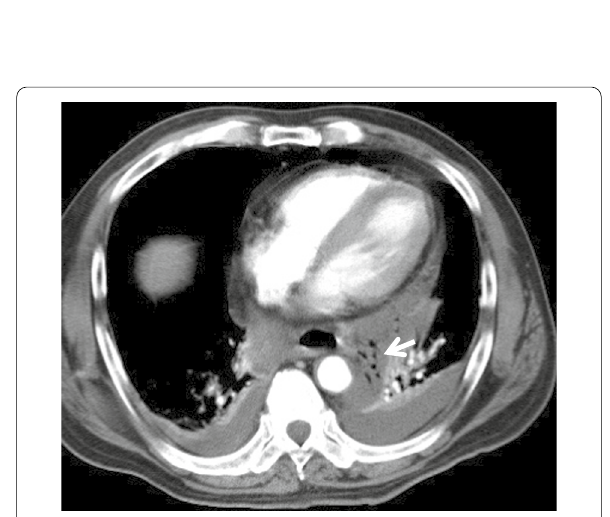
Fig. 4 CT findings. Pneumomediastinum is shown indicating mediastinitis